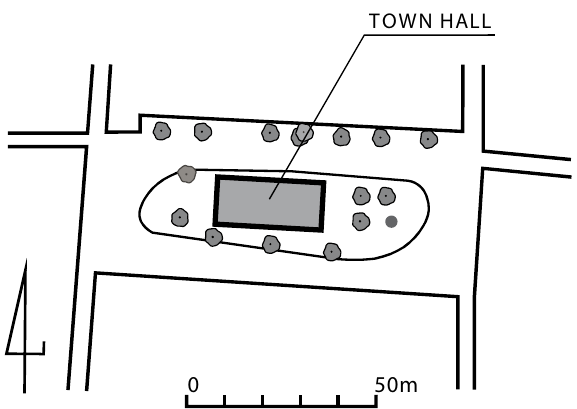
Fig. 2. Plan of market square in Prochowice town